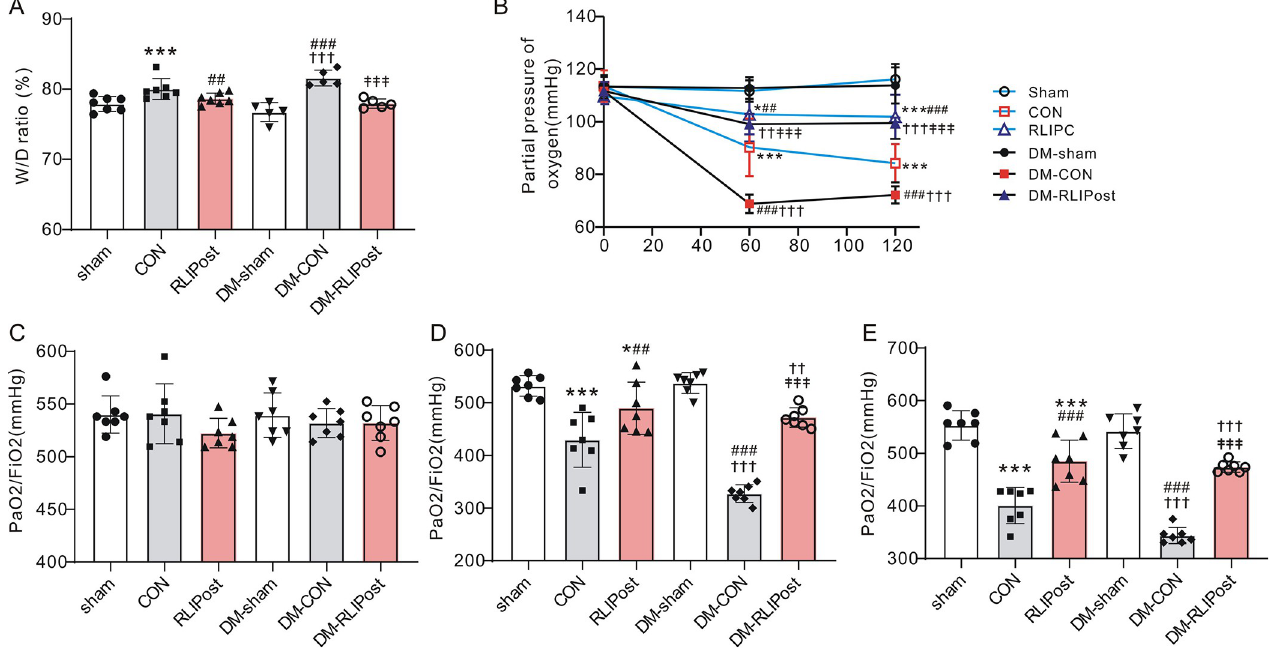
Fig 3. RLIPost ameliorates ischemia reperfusion-induced lung injury. A. Ratio of wet/dry weight in lung tissues. The data are presented as the mean ± standard deviation. ��� P < 0.001 vs. the sham lungs. ## : P < 0.01, ### : P < 0.001, vs. CON. ††† : P < 0.001, vs. DM-sham. ‡‡‡ : P < 0.001 vs. DM-CON. n = 7 per group. sham: sham-operated, CON: control, RLIPost: remote liver ischemia postconditioning. DM: STZ-induced diabetes. B. Changes in partial pressure of oxygen. n = 7 in each group. � P < 0.05, ��� P < 0.001, versus the sham group, ## P < 0.01, ### P < 0.001 versus the CON group, †† P < 0.01, ††† P < 0.001 versus the DM- sham group, ‡‡‡ : P < 0.001 vs. DM-CON. C. Changes in oxygenation index at baseline. n = 7 in each group. D. Changes in oxygenation index at 60 minutes after reperfusion. n = 7 in each group. � P < 0.05, ��� P < 0.001, versus the sham group, ## P < 0.01, ### P < 0.001 versus the CON group, †† P < 0.01, ††† P < 0.001 versus the DM-sham group, ‡‡‡ : P < 0.001 vs. DM-CON. E. Changes in oxygenation index at 120 minutes after reperfusion from sham-operated, CON and RLIPost rats; n = 7 in each group. ��� P < 0.001, versus the sham group, ### P < 0.001 versus the CON group, ††† P < 0.001 versus DM-sham, ‡‡‡ : P < 0.001 vs.